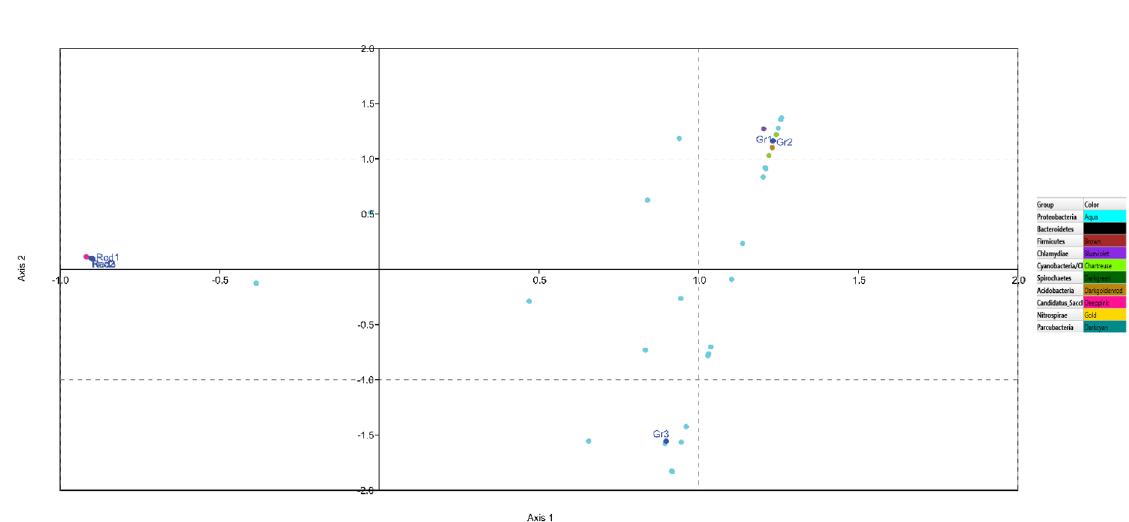
Figure 4. Correspondence analysis showing reproducibility and 16S rRNA profile similarities within Gelliodes pumila and Cliona lobata samples. CA ordination for triplet microbial community profiles from G. pumila (Gr1, 2 and 3) and C. lobata (Red1, 2 and 3) represented in dots highlights the species belonging to 10 different phyla in different colour. Triplicate G. pumila samples representing Gr1 and 2 found to cluster closely whereas, Gr3 cluster more distantly along the first ordination axis. C. lobata -derived triplicates (Red 1, 2 and 3) also show similar diversity pattern. CA plot highlights the abundance of Proteobacteria (shown in figure as aqua dots) and the convergence of uncultured Candidatus Saccharibacteria phyla represented in deep pink dots. Different colour dots adjacent to the G. pumila sponge triplets (Gr1, Gr2 and Gr3) has symbolized its high bacterial diversity as compared to C. lobata at phyla